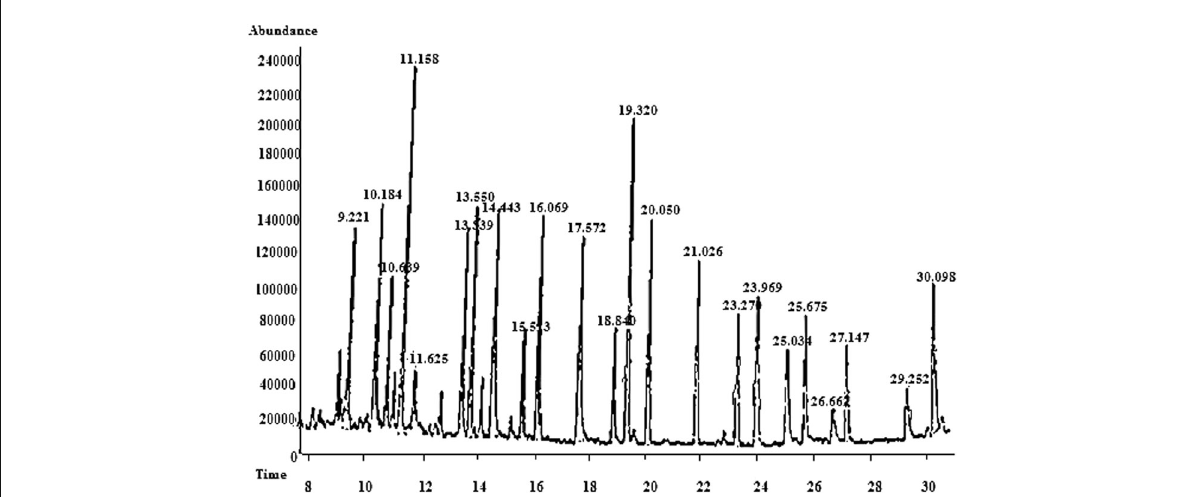
Fig. 6 GC/Mass Chromatogram of standard compounds. Retention Times (min): α - HCH (9.09); β - HCH (10.12); Quintozene (10.50); Chlorothionil (11.69); Chlorpyrifos-Me (13.19); Heptachlor (13.44); 4,4-Dichlorobenzophenone (14.38); Chlorpyrifos (15.87); Cyprodinil, (17.47); Chlorodane-Gamma (19.07); α -endosulfane (19.82); Dieldrin (21.54); Endrin (22.981); β -endosulfane (23.683); p,p-DDD (24.802); endosulfane Sulfate (26.855); piperonyl- butoxide (29.93) and methoxychlor